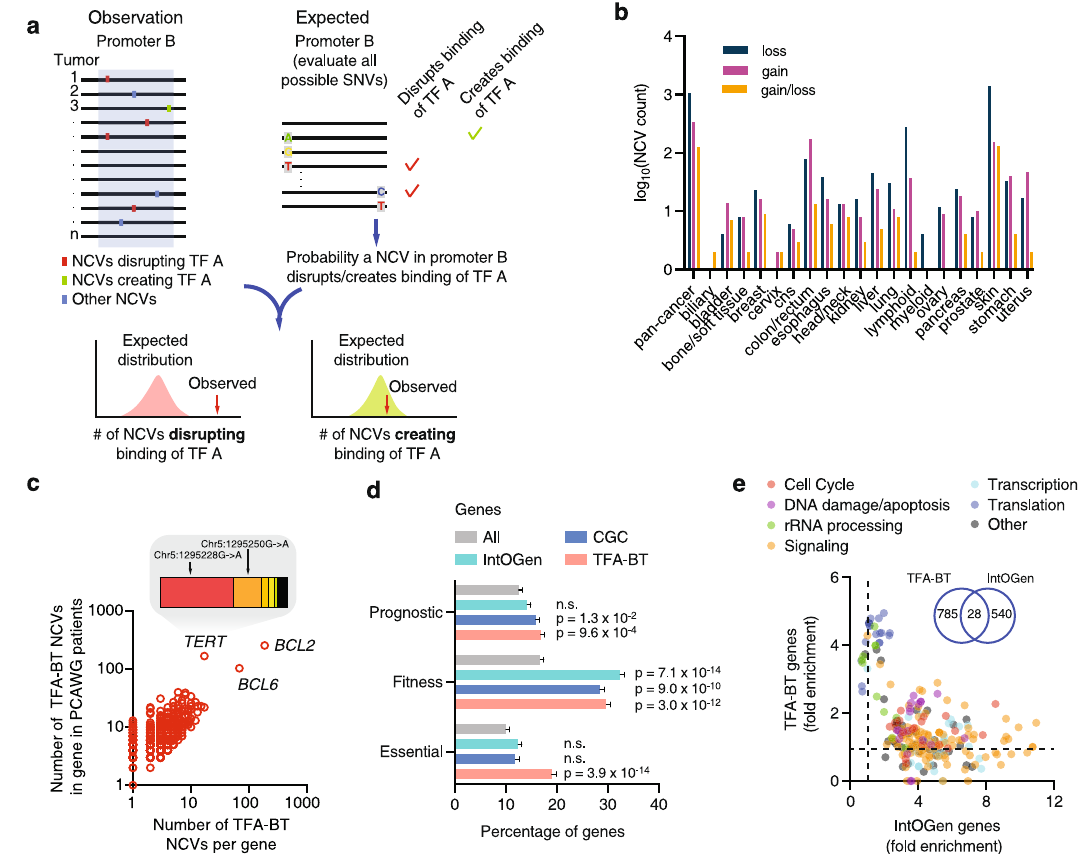
Fig. 1 | Identi fi cation of TFA-BT NCVs. a Overview of the TFA-BT approach. The number of observed NCVsacross tumor samples that disrupt (or create) a binding site of TF A in promoter B is compared to the expected probability distribution to identify signi fi cant promoter-TF associations. b Number of TFA-BT NCVs with predictedgainand/orlossofTFbindingpercancertype. c Scatterplotshowingthe number of different TFA-BT NCVs per gene in the PCAWG cohort versus the number of TFA-BT NCV events in the corresponding promoter in patients from PCAWG. Insertshows fraction of patients in PCAWG foreachmutation inthe TERT promoter. d Percentage of prognostic (i.e., genes whose expression levels are